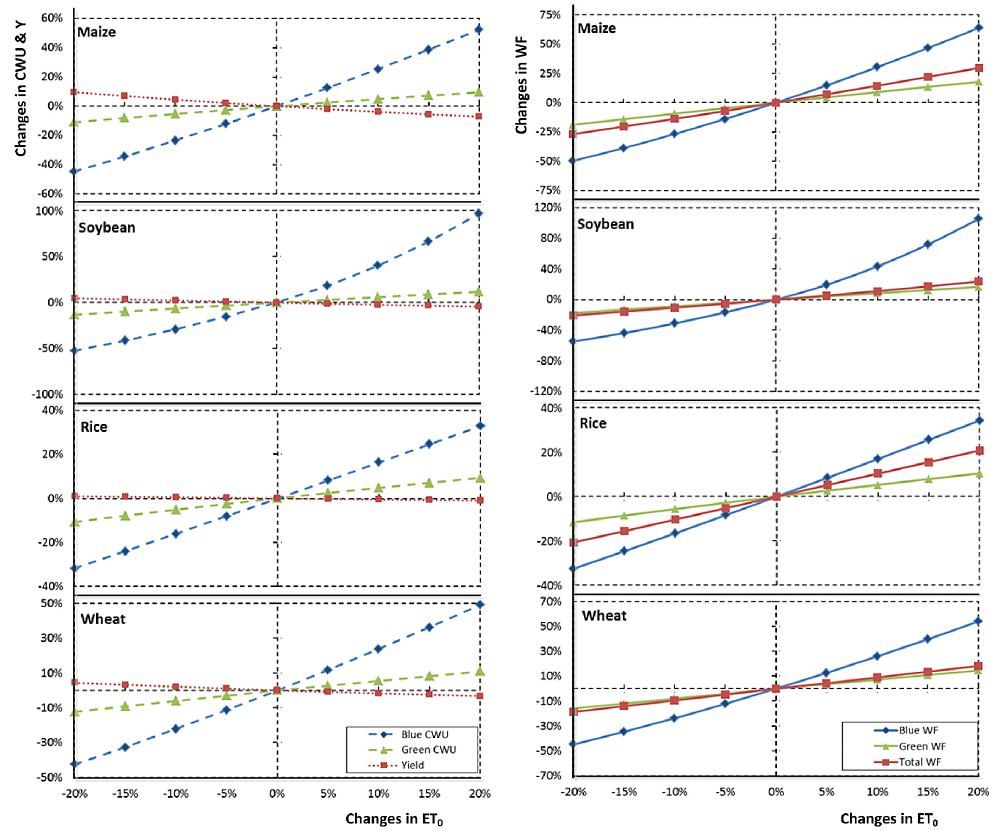
Figure 4. Sensitivity of CWU, Y and WF to changes in reference evapotranspiration (ET 0 ),